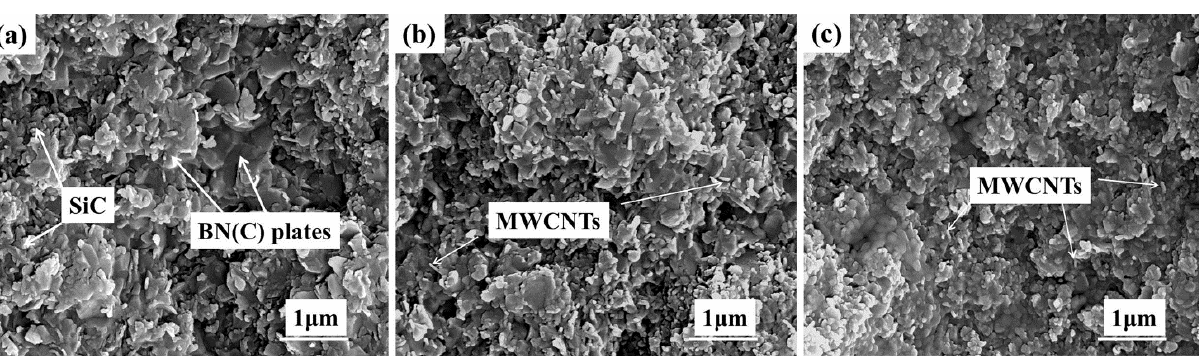
Fig. 1 SEM microstructures of Si 2 BC 3 N ceramics: (a) T0, (b) T1, and (c)